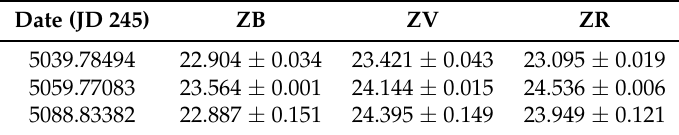
Table 4. Zero point table for the 3C 454.3 blazar using B, V, and R filters at each epoch.